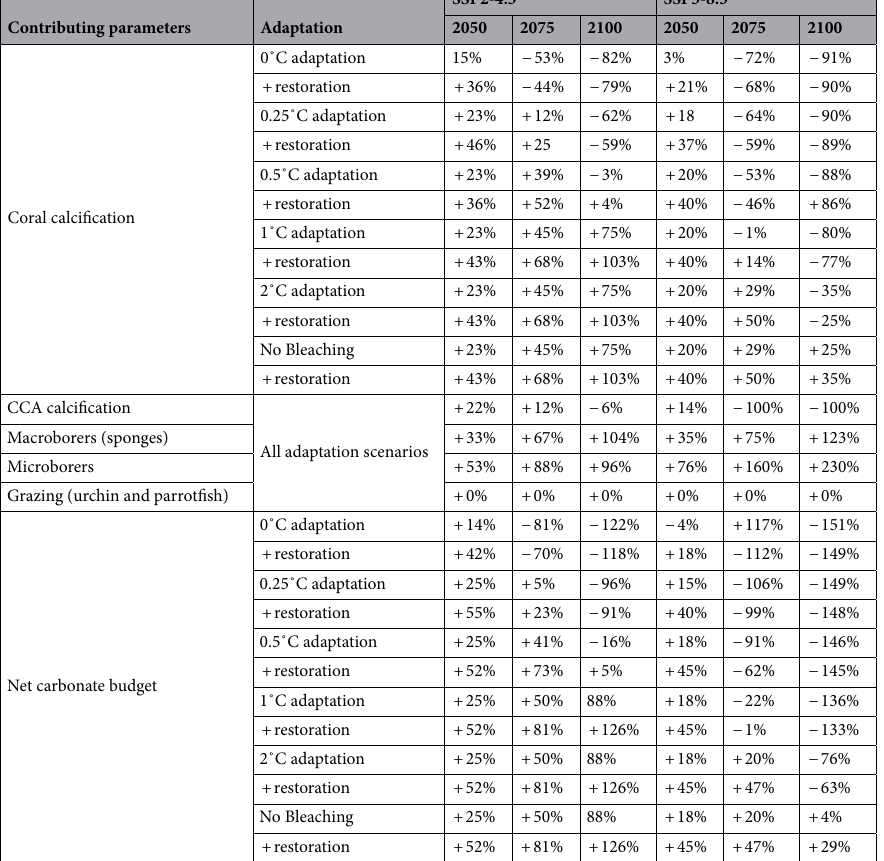
Table 1. Mean percentage change in relative contribution of each process involved in the calculation of net carbonate budgets and mean change in net carbonate accretion. Percentage changes due to warming and OA in each greenhouse gas emission scenario are calculated for 2050, 2075 and 2100, relative to the year 2019. Percentage change in coral calcification contribution to budgets in 2050 and 2100 are also shown for different adaptation scenarios and with